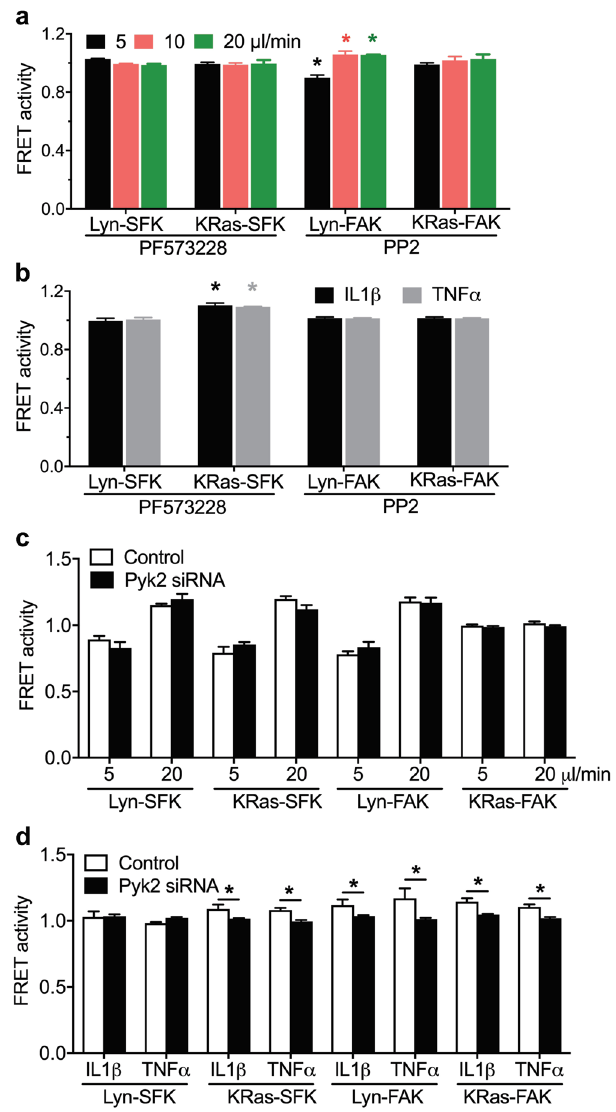
Figure 4. Distinct molecular hierarchy of SFK and FAK under flow and pro-inflammatory cytokines. ( a ) The flow-driven activities of SFK and FAK at different subcellular domains in cells pretreated with FAK and SFK inhibitors. Cells transfected with either a Lyn-SFK or KRas-SFK biosensor were pretreated with PF573228 (1 μ M, 1 hour). Cells transfected with either a Lyn-FAK or KRas-FAK were pretreated with PP2 (10 μ M, 1 hour). The bar graphs represent SFK and FAK activities at 60 min after the application of fluid flow (5, 10, or 20 μ l/min). The activities were normalized to those at 0 min. * p < 0.05 compared to the corresponding FRET activities at 0 min. Lyn-SFK under PF573228, n = 6, 7, 7 in 5, 10, 20 μ l/min; KRas-SFK under PF573228, n = 8, 8, 8 in 5, 10, 20 μ l/min; Lyn-FAK under PP2, n = 8, 10, 10 in 5, 10, 20 μ l/min; KRas-FAK under PP2, n = 8, 10, 10 in 5, 10, 20 μ l/min. ( b ) The pro-inflammatory cytokine-induced activities of SFK and FAK at different subcellular domains in cells pretreated with FAK and SFK inhibitors. Cells transfected with either a Lyn-SFK or KRas-SFK biosensor were pretreated with PF573228. Cells transfected with either a Lyn-FAK or KRas-FAK biosensor were pretreated with PP2. The bar graphs represent SFK and FAK activities at 120 min after the addition of the cytokines (10 ng/ml TNF α or 1 ng/ml IL1 β ). The activities were normalized to those at 0 min. * p < 0.01 compared to the corresponding FRET activities at 0 min. Lyn-SFK under PF573228, n = 7, 7 in IL1 β and TNF α ; KRas-SFK under PF573228, n = 7, 10 in IL1 β and TNF α ; Lyn-FAK under PP2, n = 8, 11 in IL1 β and TNF α ; KRas-FAK under PP2, n = 10, 10 in IL1 β and TNF α . ( c ) The flow-driven activities of SFK and FAK at different subcellular domains in cells pretreated with either non-specific control (NC) siRNA or Pyk2 siRNA. Cells were co-transfected with either NC or Pyk2 siRNA and one of FRET biosensors, and then subjected to 5 or 20 μ l/min fluid flow for 1 hour. The bar graphs represent SFK and FAK activities at 60 min after flow application. The activities were normalized to those at 0 min. Lyn-SFK under 5 μ l/min, n = 6, 6 in NC, Pyk2 siRNA; Lyn-SFK under 20 μ l/min, n = 6, 6 in NC, Pyk2 siRNA; KRas-SFK under 5 μ l/min, n = 10, 8 in NC, Pyk2 siRNA; KRas- SFK under 20 μ l/min, n = 12, 8 in NC, Pyk2 siRNA; Lyn-FAK under 5 μ l/min, n = 6, 8 in NC, Pyk2 siRNA; Lyn-FAK under 20 μ l/min, n = 9, 10 in NC, Pyk2 siRNA; KRas-FAK under 5 μ l/min, n = 6, 8 in NC, Pyk2 siRNA; KRas-FAK under 20 μ l/min, n = 8, 10 in NC, Pyk2 siRNA. ( d ) The pro-inflammatory